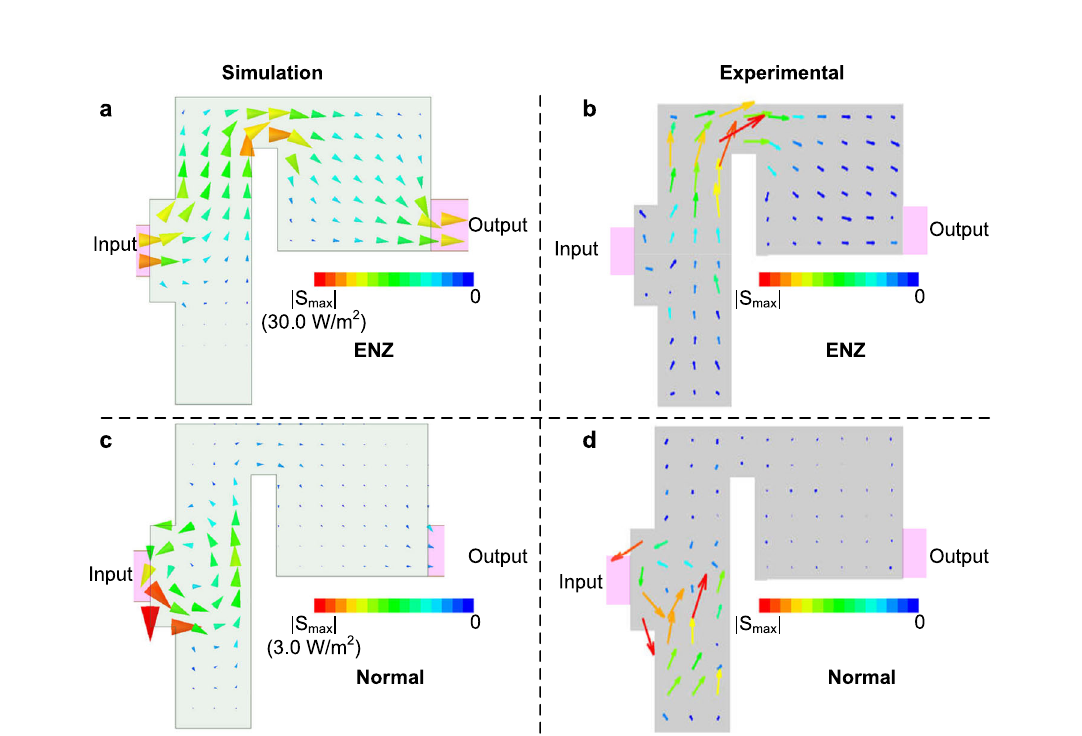
Fig. 3 | Simulated and experimental observation of the power fl ow within doped ENZ and normal media. a , b the simulated and experimentally imaged power fl ow of the doped ENZ medium at 3.06GHz, c , d the simulated and